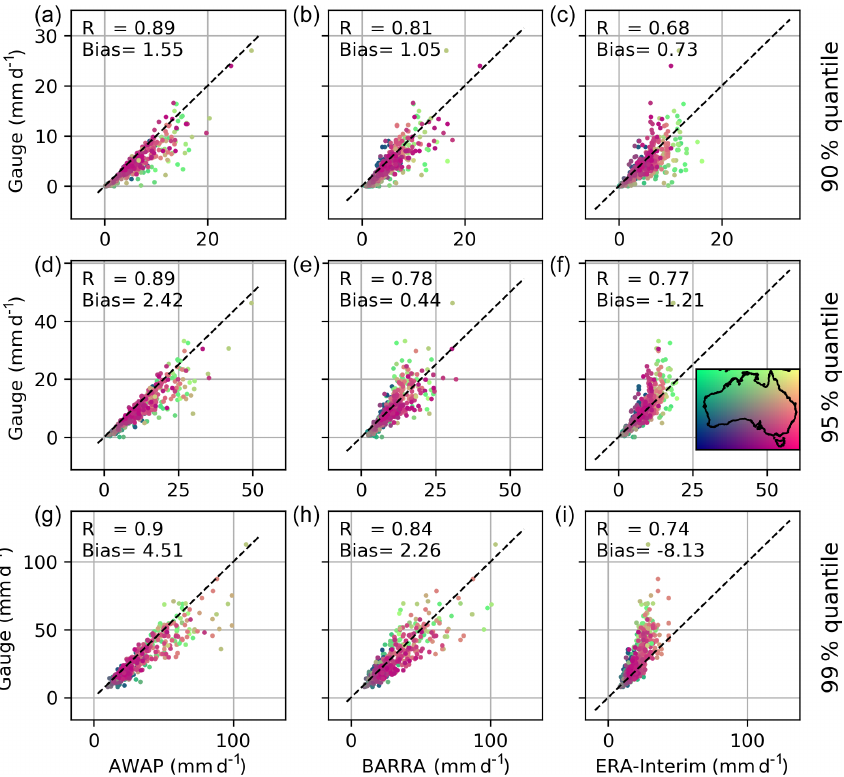
Figure 5. Quantile estimates (mmd − 1 ; 90%, 95%, and 99% in a–c , d–f , and g–i , respectively) from gridded datasets (AWAP, BARRA, and ERA-Interim) and observations at gauge locations. The colour of the scatter indicates the location of the